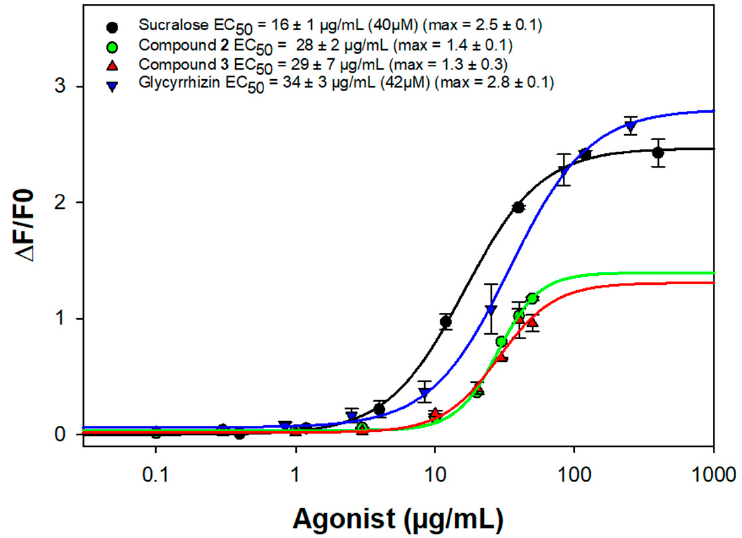
Figure 3. Activation of TAS1R2/TAS1R3 by sucralose, compound 2 , 3 and glycyrrhizin. Structurally, compounds 2 and 3 shared with glycyrrhizin a 3- O - β -D-glucuronopyranosyl linkage, a ketone group, and an oxidated 30 β -CH 3 (Figure 1). Previous studies high-